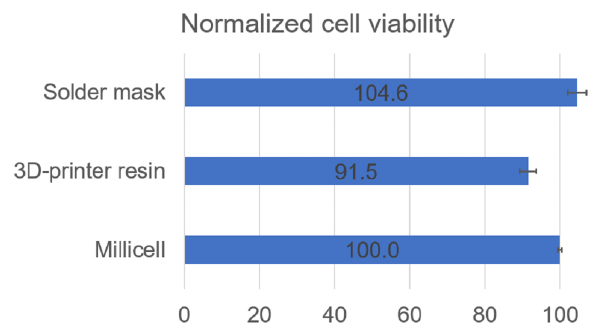
Figure 5. Biocompatibility measured in open culture systems. Bar plot displaying the viability of retinal cells after being cultured with three different materials for 48 h in open systems. Percentage of viable cells after culture of retinal explants onto Millicell membrane, PCB, and MEA + 3D printer resin. The error bars represent the standard deviation.